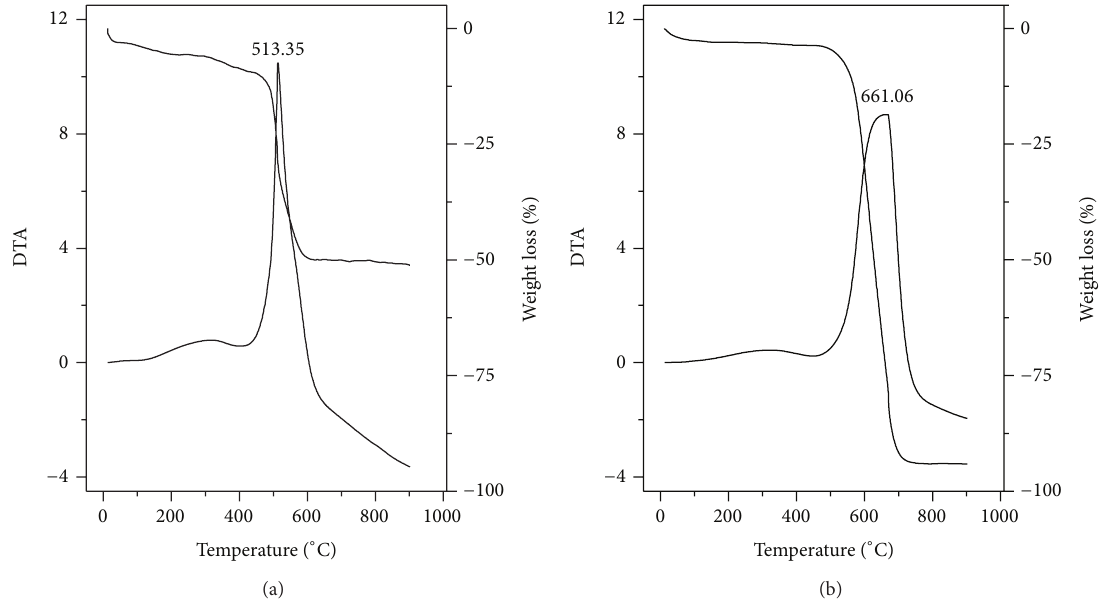
Figure 5: TG and DTA curves of the obtained products from the catalysts (a) Ni/MgO and (b) Ni-Cu/MgO calcined at 500 ∘ C with reaction temperature 650 ∘